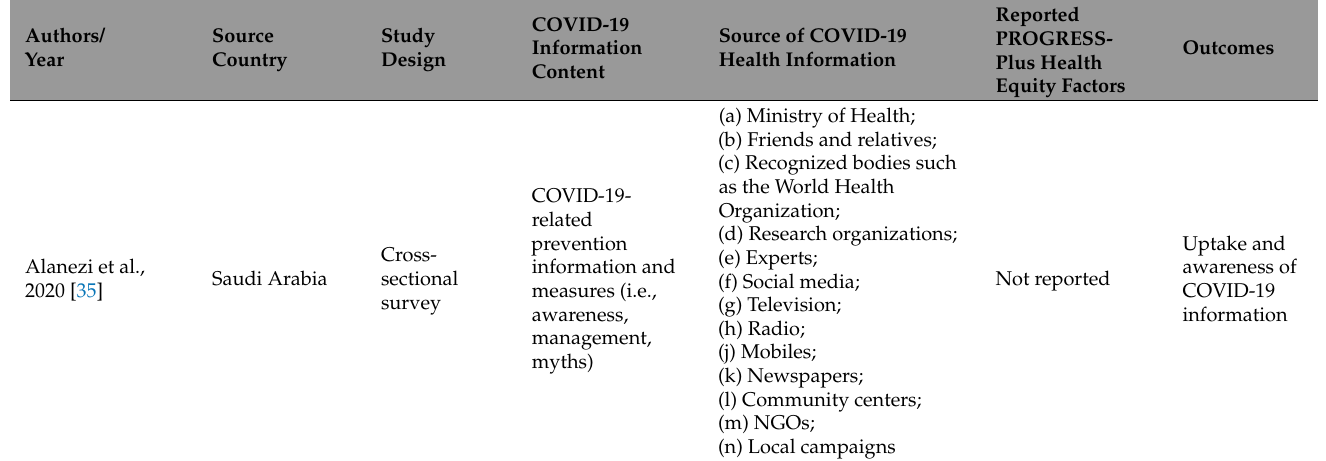
Table 2. Characteristics of included studies, ordered alphabetically by